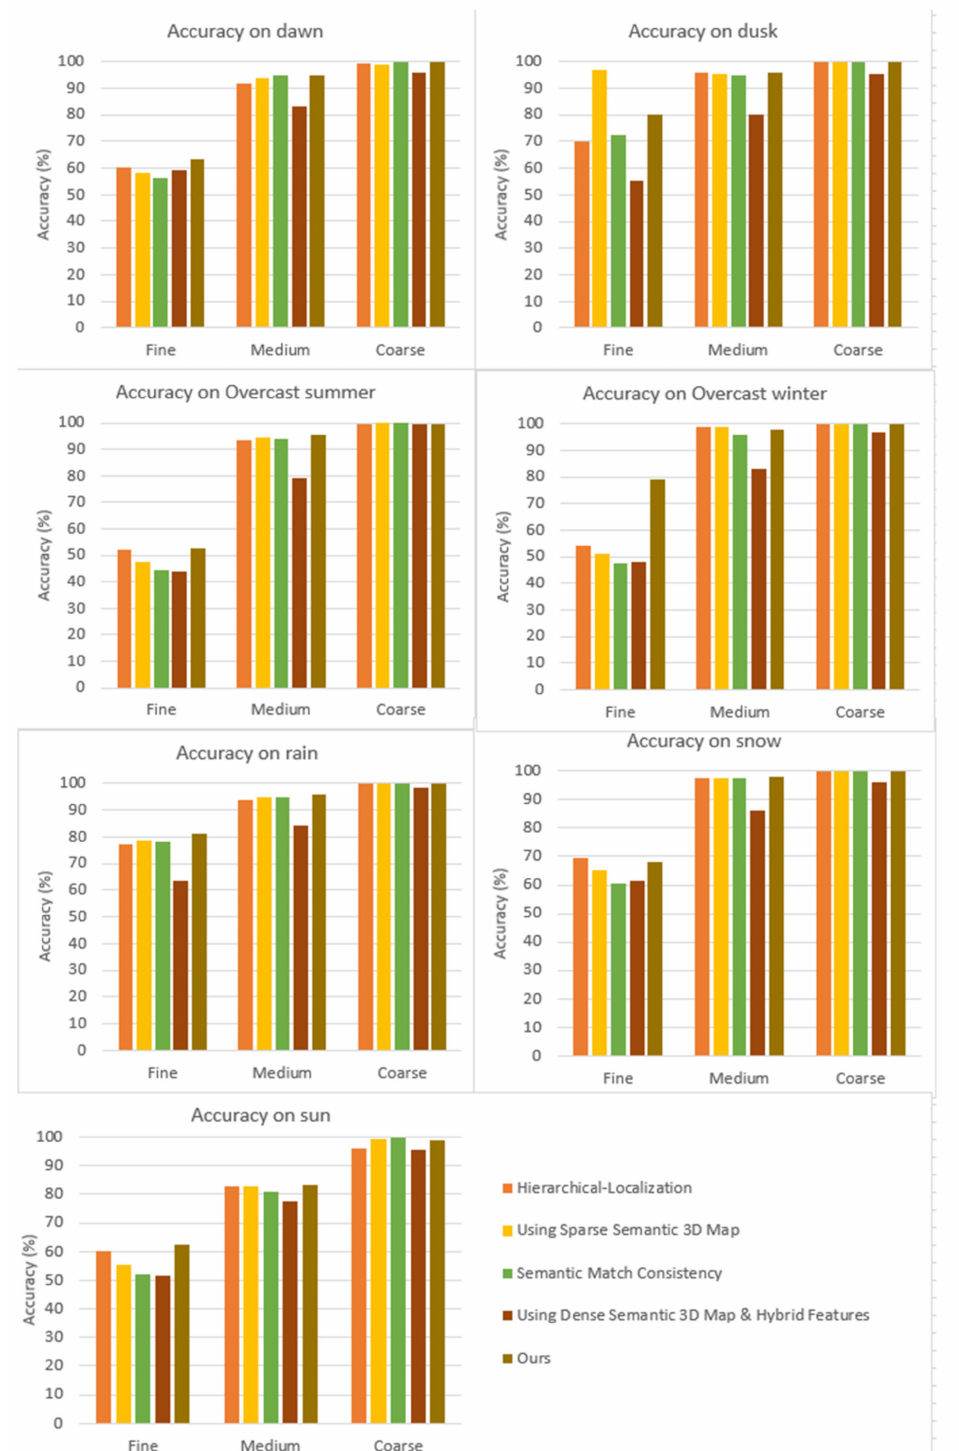
Figure 5. Performance on the five different methods for the RobotCar Season